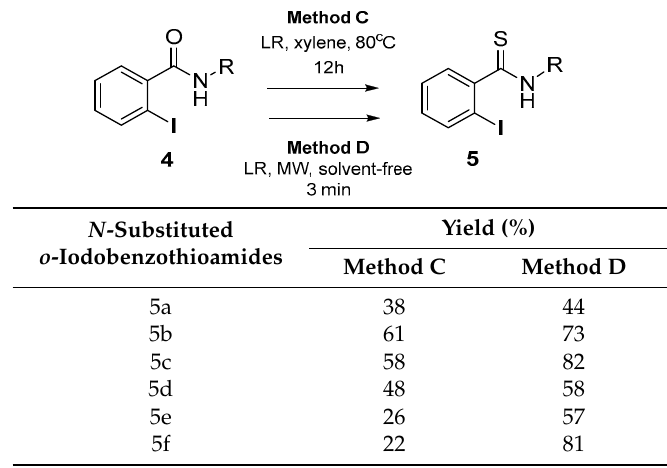
Table 1. Thioamide synthesis—Method C and D .